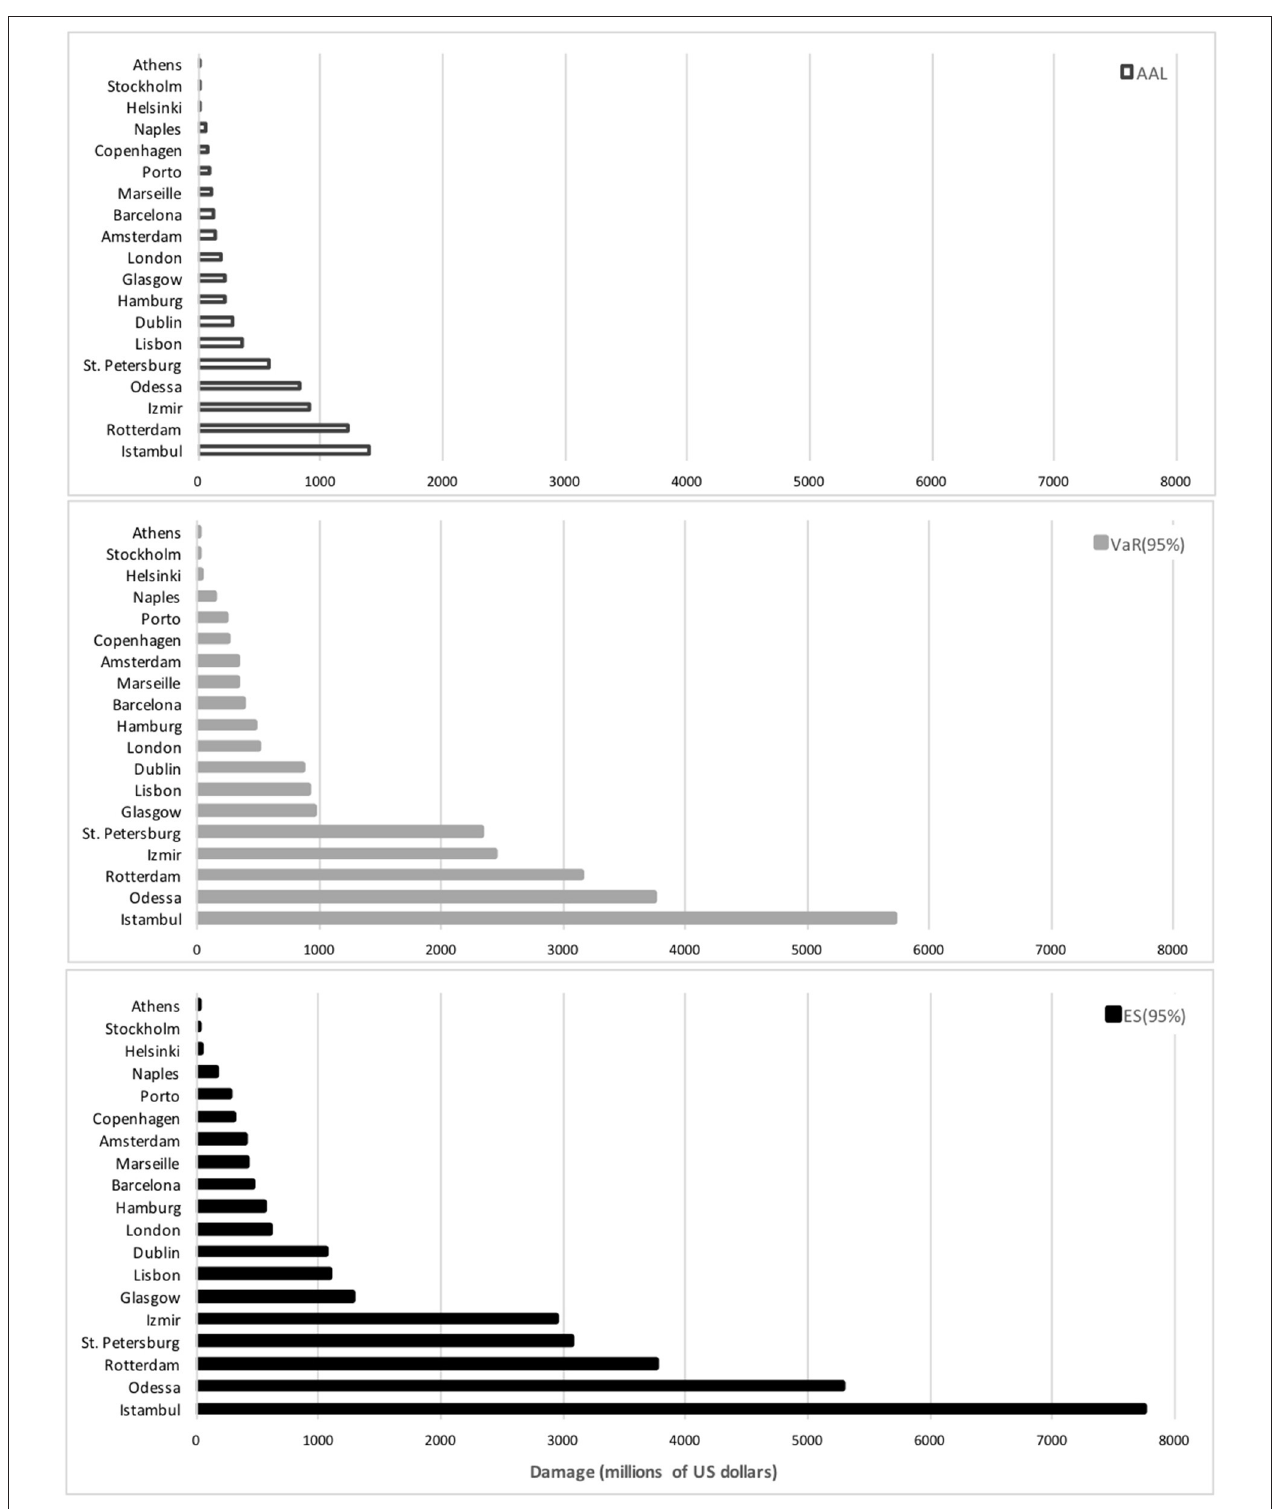
FIGURE 4 | Risk for main European coastal cities ranked by Expected Shortfall (ES) in 2050, under RCP8.5. Damage is measured in millions of US dollars.